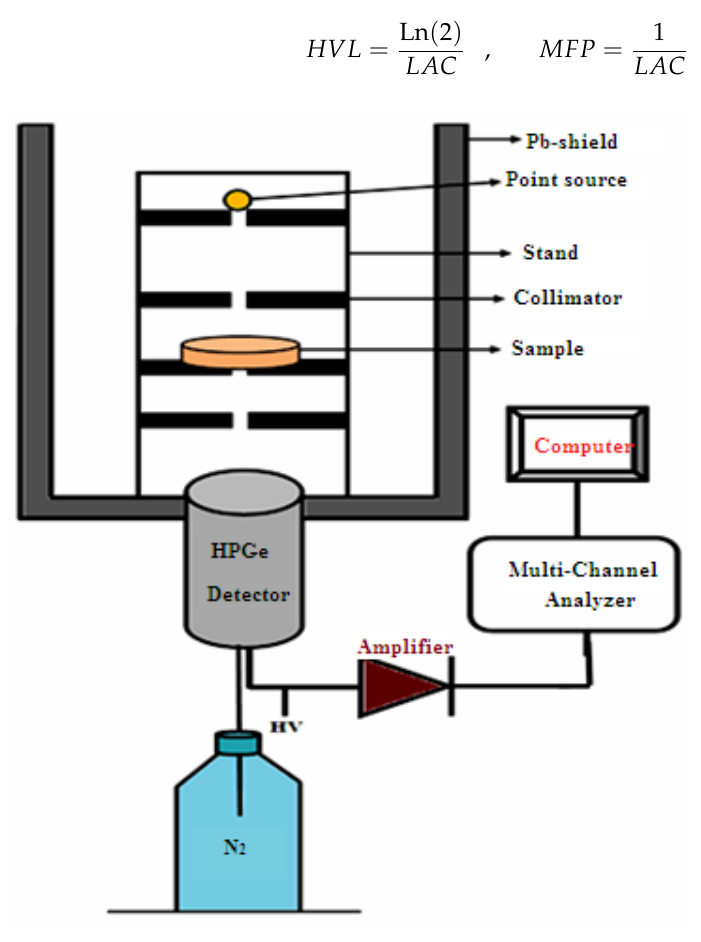
Figure 4. The illustration setup of the experimental work.